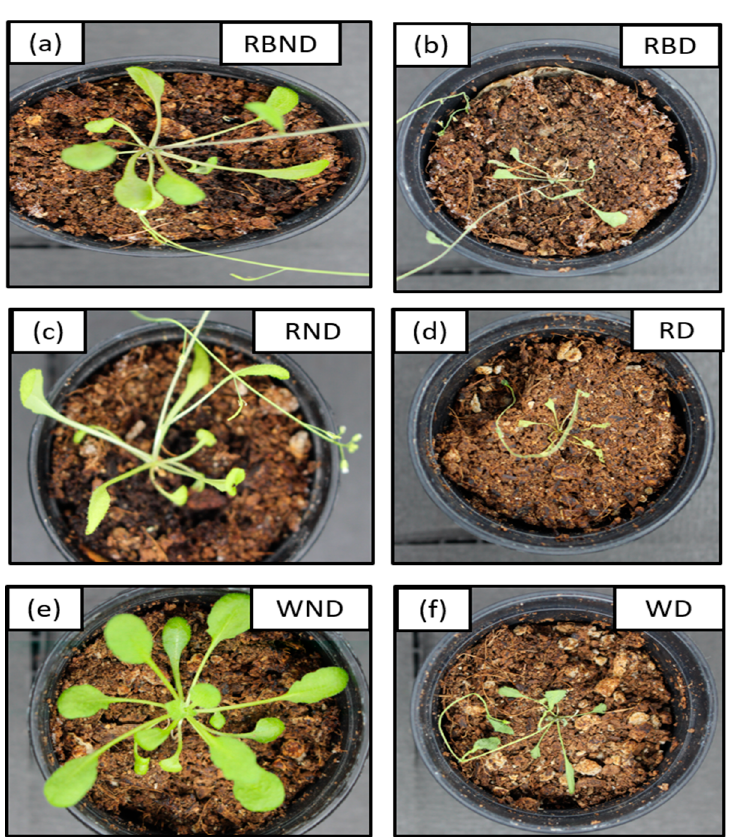
Figure 16 . RGB images of non-drought and drought conditions of A. thaliana plants under different LED lightning conditions. Here, RBND and RBD ( a , b ) represents red + blue non-drought and red + blue drought, RND and RD ( c , d ) represents red non-drought and red drought, and WND and WD ( e , f ) represents white non-drought and white drought respectively.